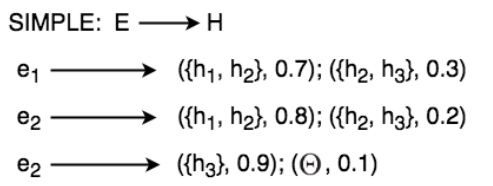
Figure 5. Semi-graph for representing simple rules.